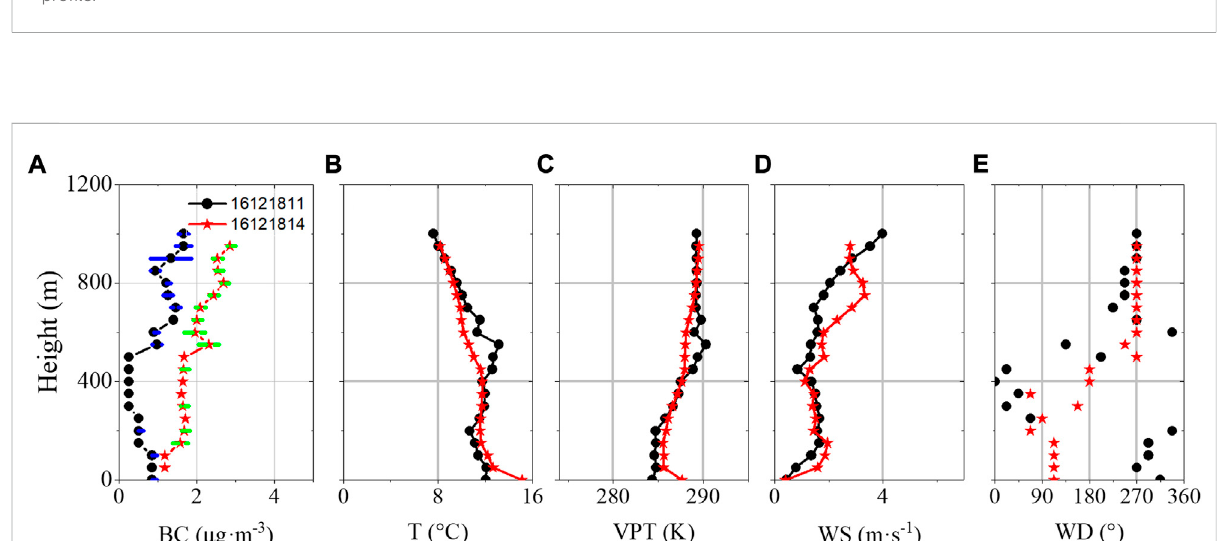
FIGURE 4 Thermally controlled unstable boundary layer BC, T, VPT, WS and WD contours. The black line indicates the contours of each element at 2016121811 and the red line indicates the contours of each element at 2016121814. Green and blue lines are BC error bars. (A) black carbon